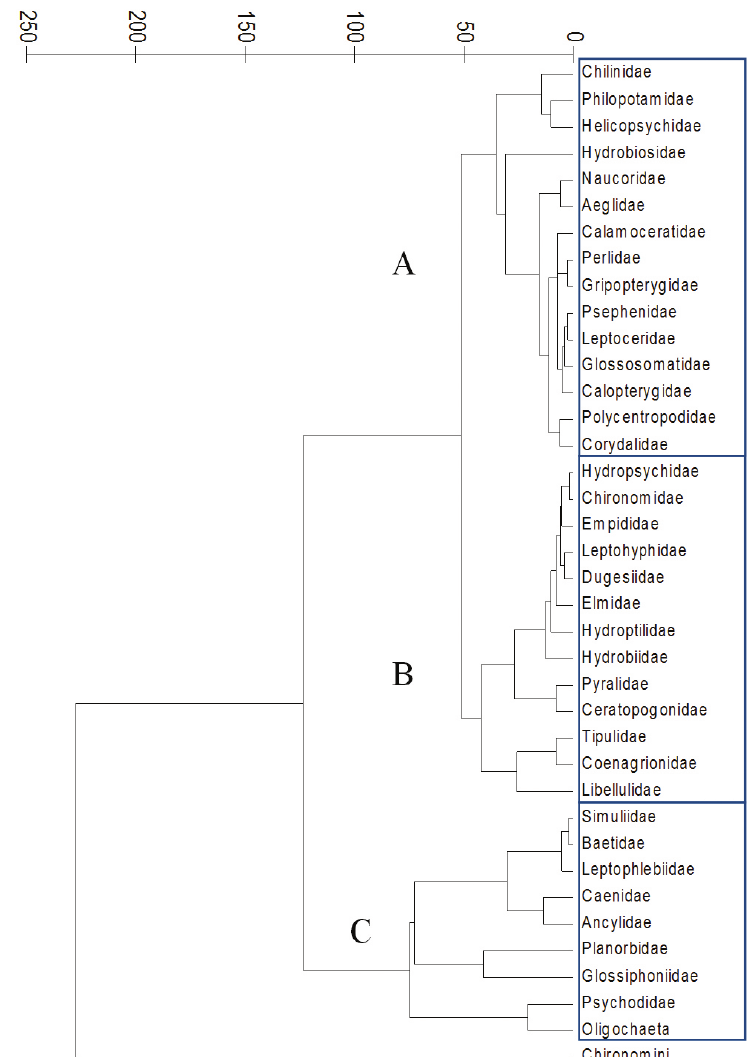
Figure 4. Similarity (Euclidean Distance) of benthic macroinvertebrate fauna according to Chemical Index in 35 highland streams at the northeast region of Rio Grande do Sul, Brazil. A) Sensitive taxa; B) Intermediate taxa; C) Tolerant taxa. Cophenetic correlation coefficient =